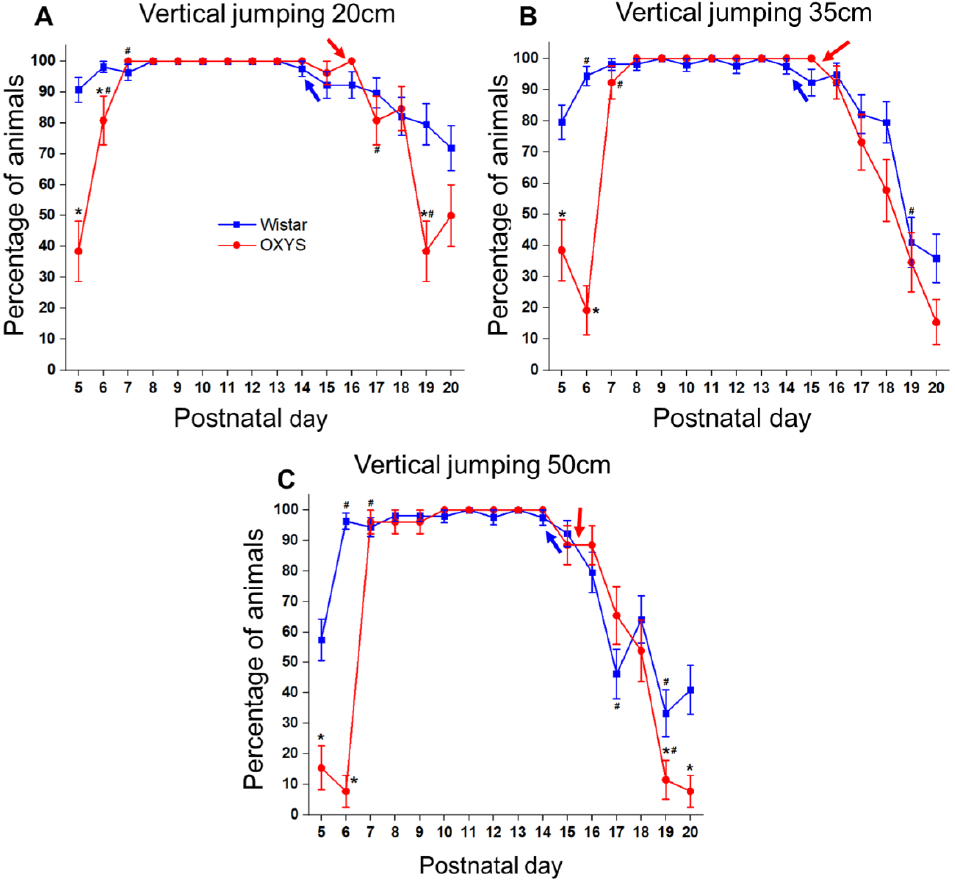
Figure 5. The ability of OXYS and Wistar pups to jump. ( A ) Jumping from a height of 20 cm; ( B ) jumping from a height of 35 cm; ( C ) jumping from a height of 50 cm. * p < 0.05 as compared to control (Wistar) rats; # p < 0.05 as compared to a previous day; blue arrow: eye-opening in Wistar pups; red arrow: eye opening in OXYS pups. The data are presented as the mean ± SEM.